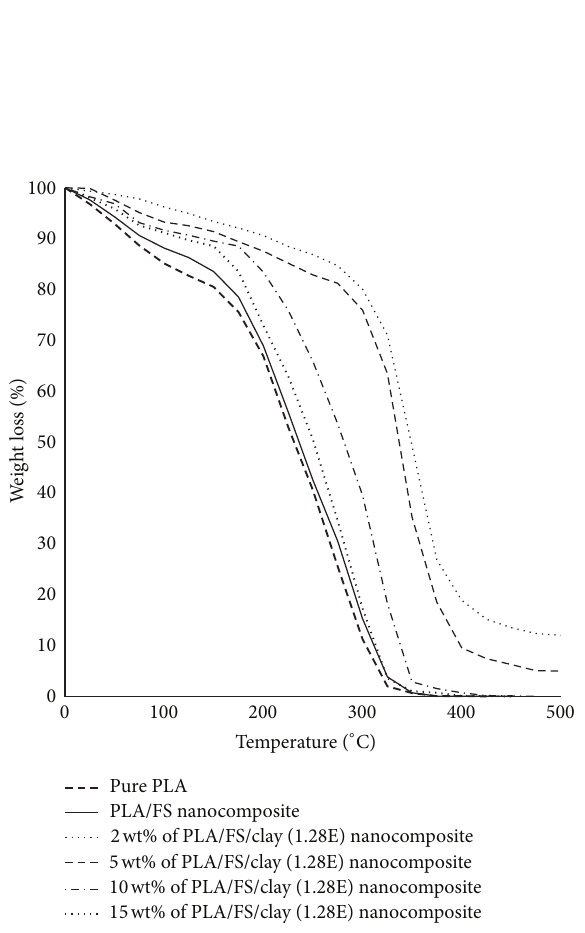
Figure 5: TGA curves for PLA/FS/clay (1.28E)